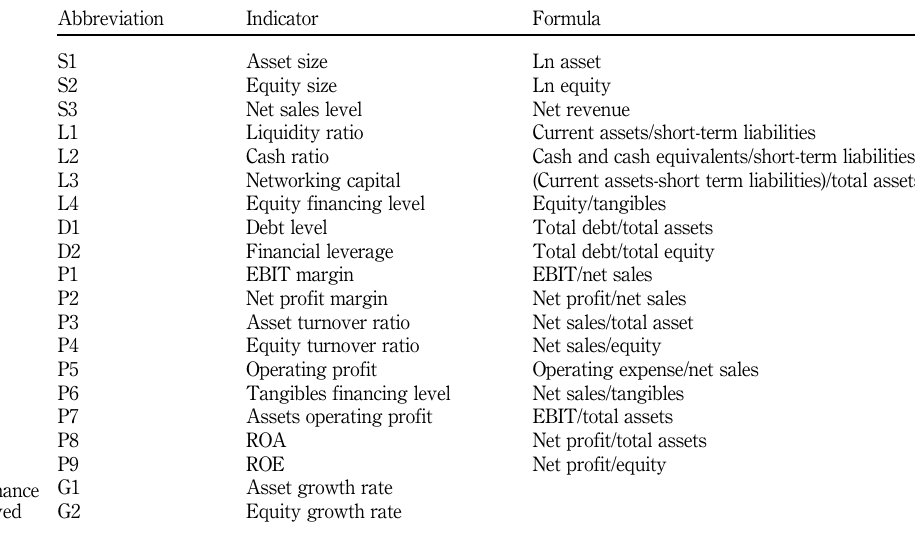
Table III. Financial performance indicators